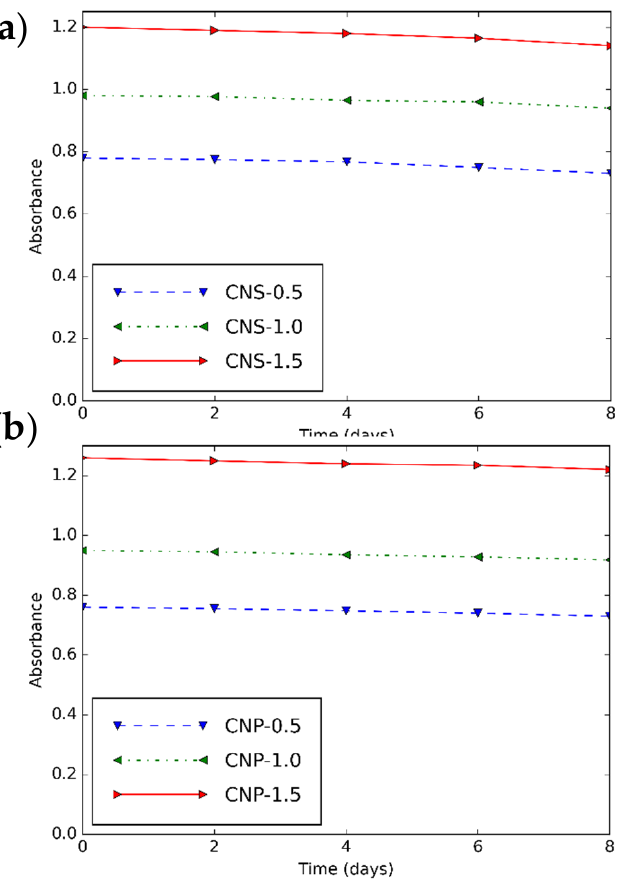
Figure 7. Maximum absorbance—time diagram of ( a ) CNS and ( b ) CNP nanofluids for different concentrations.